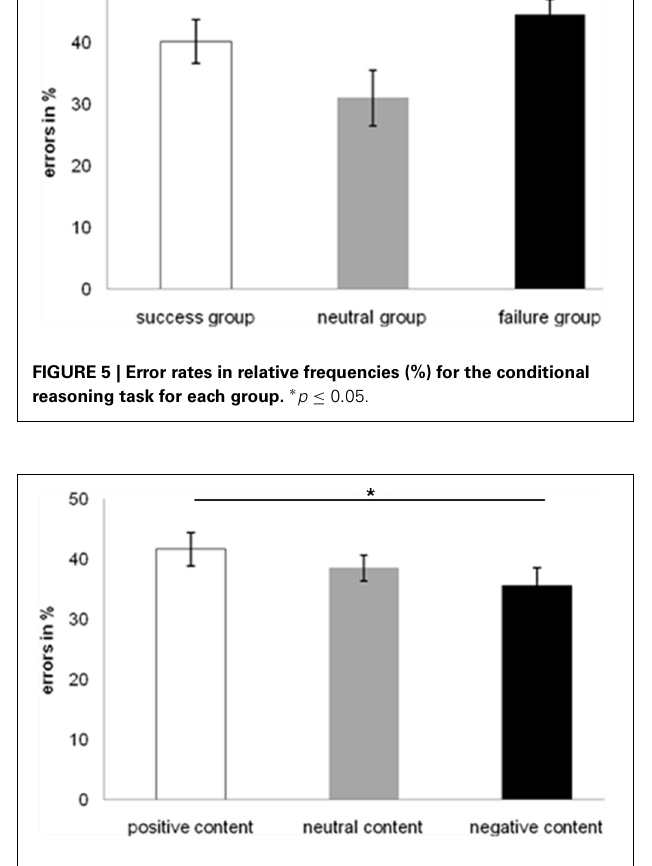
FIGURE 6 | Error rates in relative frequencies (%) for the conditional reasoning task for each type of content. ∗ p ≤ 0 . 05.